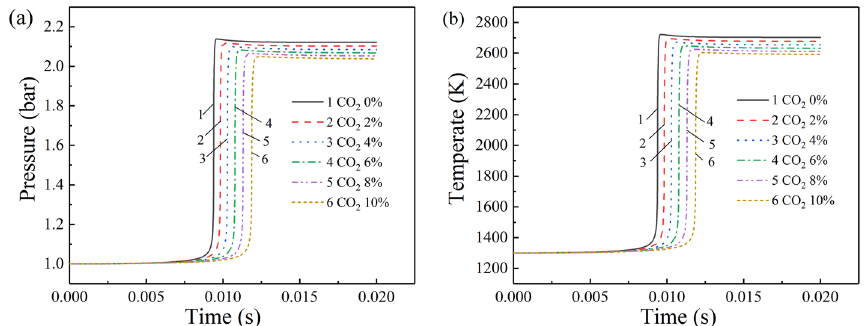
Figure 1. Variation of explosion pressure and temperature with time under different CO 2 volume fractions at 7% CH